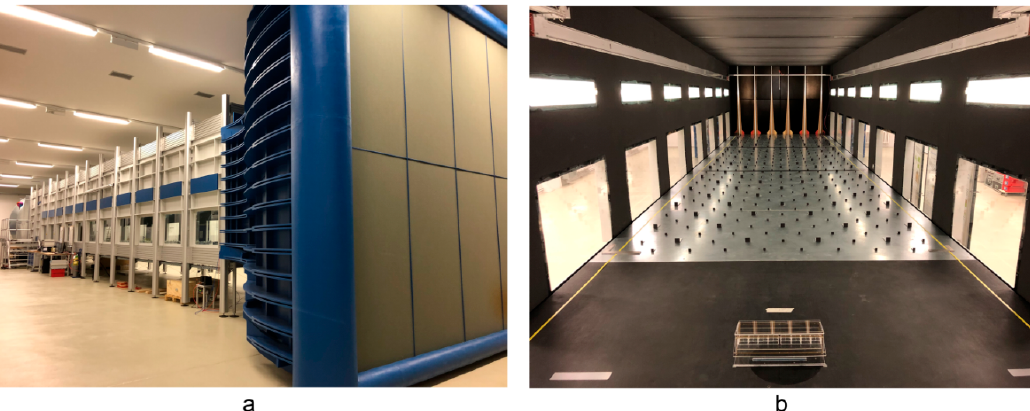
Figure 2. Photographs of the boundary layer wind tunnel (BLWT) at the Leibniz Institute for Agricultural Engineering and Bioeconomy (ATB), Germany. ( a ) Exterior view of the BLWT viewed from the air inlet; ( b ) interior view of the test section of the BLWT with the 1:50 scaled pig barn model.